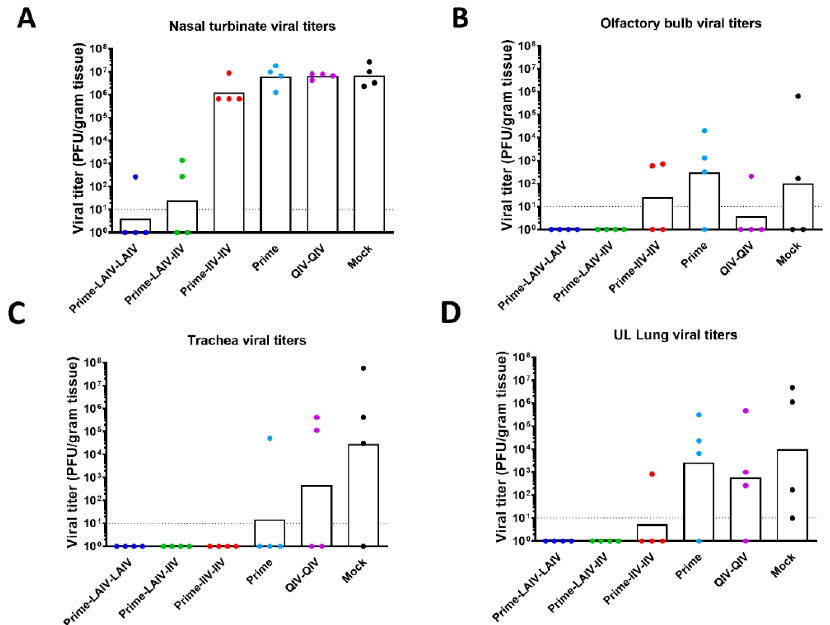
Figure 6. Viral replications following pH1N1 virus challenge infection. Viral titers of vaccinated groups or mock animals were measured by plaque assays. Viral titers from the ( A ) nasal turbinate and ( B ) olfactory bulb of the upper respiratory tract, and viral titers from the ( C ) trachea and ( D ) lung (left medial bronchus of the upper lobe) of the lower respiratory tract were determined on day 4 post-infection. White bars denote the GMT with individual scatter dot plots. Each point indicates the titer for each individual ferret ( n = 4/group). LAIV-LAIV, LAIV-IIV, IIV-IIV, Prime-only, QIV-QIV vaccinated, and mock animals are shown as blue, green, red, light blue, purple, and black, respectively. The black dashed line indicates the limit of detection for the assay. Data were compared to mock vaccinated animals with one-way ANOVA followed by a Dunnett’s multiple comparison test (single time point).